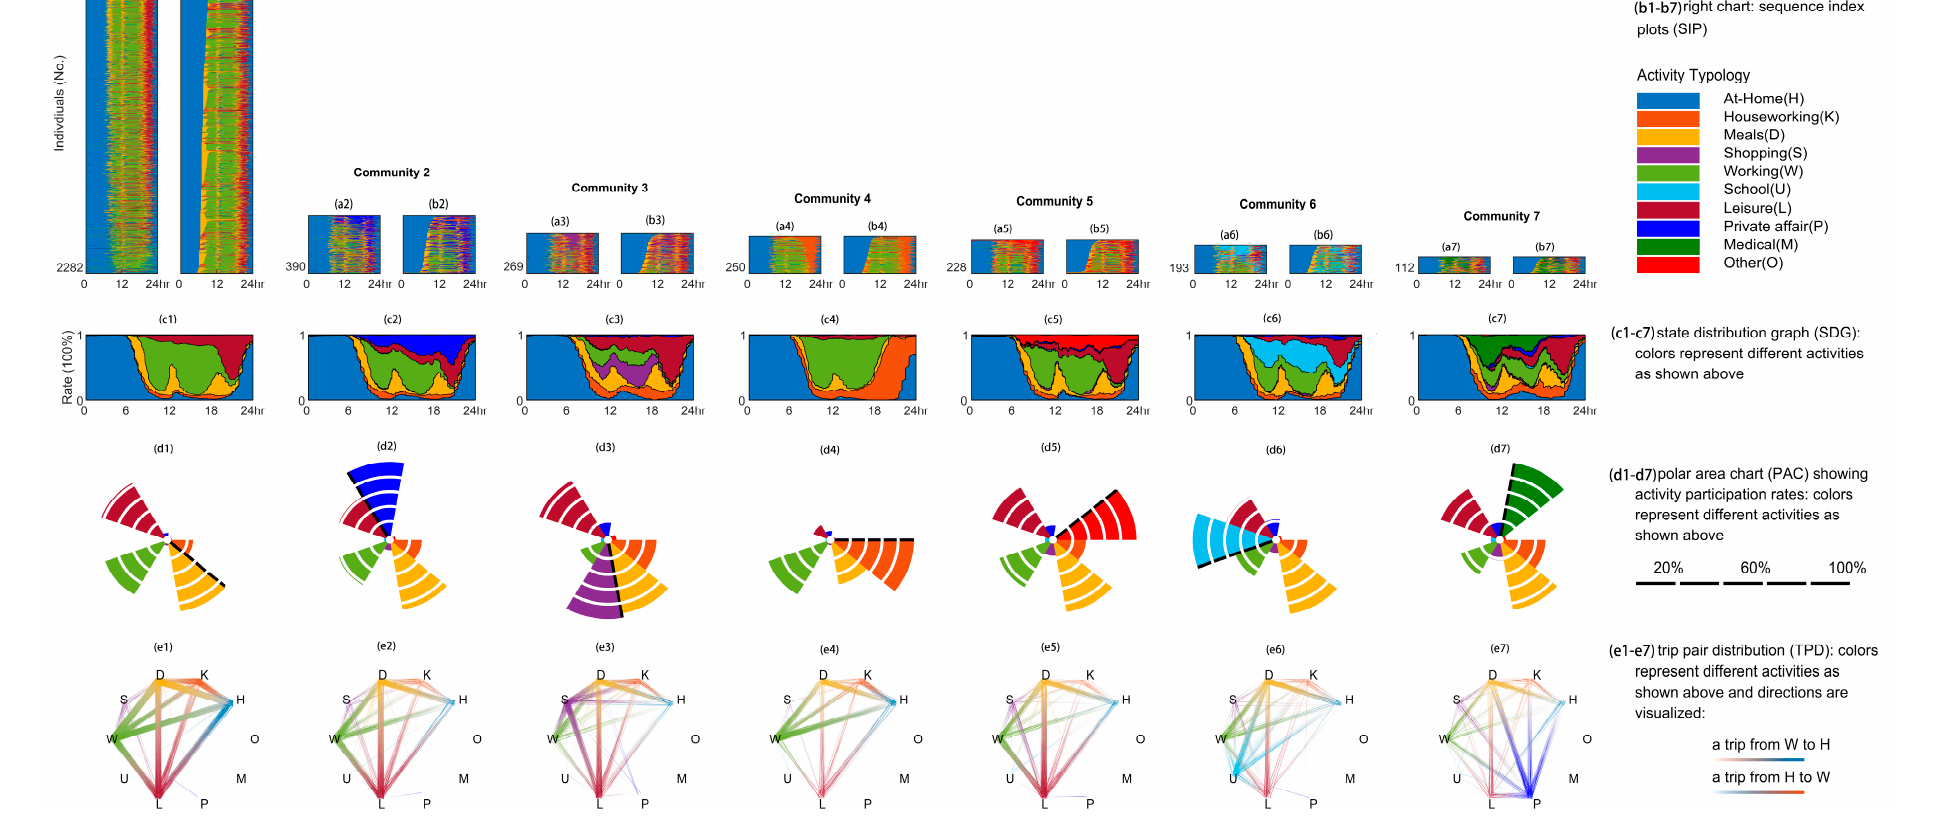
Figure 3. Activity-travel patterns of seven largest communities detected based on the complex network